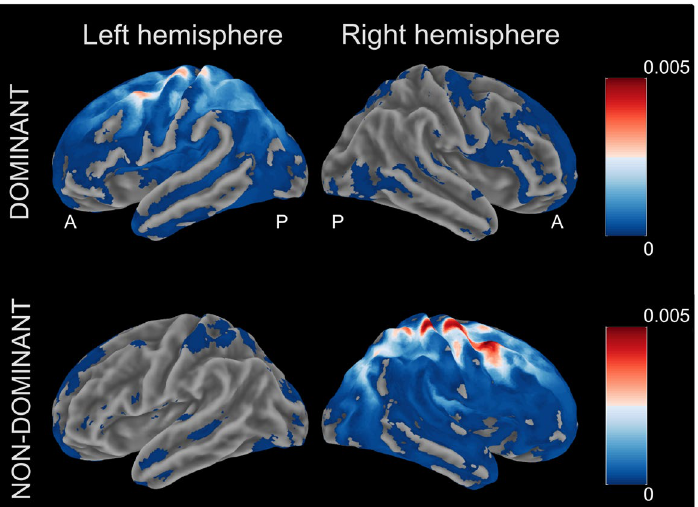
Figure 3. Dynamic imaging of coherent sources. Displays age-related differences in localization of beta-range peak coherence with active FDI muscle for the dominant and non-dominant hand. Sources are displayed on the template MNI brain provided in the visualization tool MRIcron at z = 60. A = Anterior; P = Posterior; L = Left; R = Right.